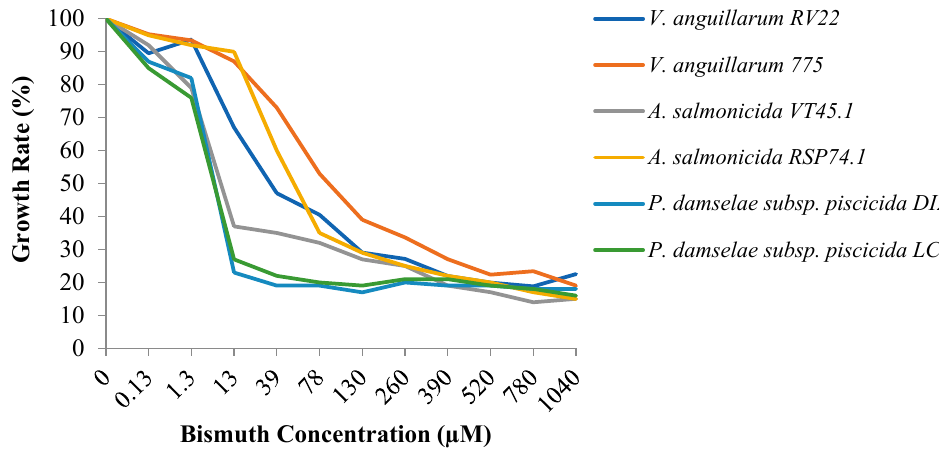
Figure 1. Maximum growth achieved by two strains of the three main fish pathogens studied, when they were grown in Tryptic Soy Broth with 1% NaCl (TSB-1) containing bismuth–deferiprone. Growth values shown are the ratio of the growth achieved in TSB-1 at each bismuth concentration divided by growth in TSB-1 without bismuth.